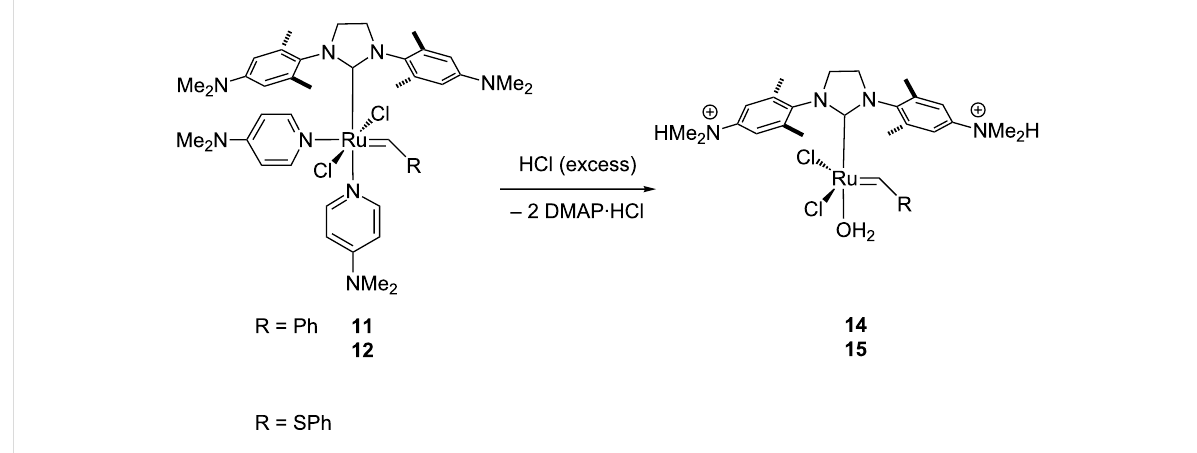
Scheme 4: Proposed formation of catalytic species 14 and 15 under emulsion ROMP conditions.